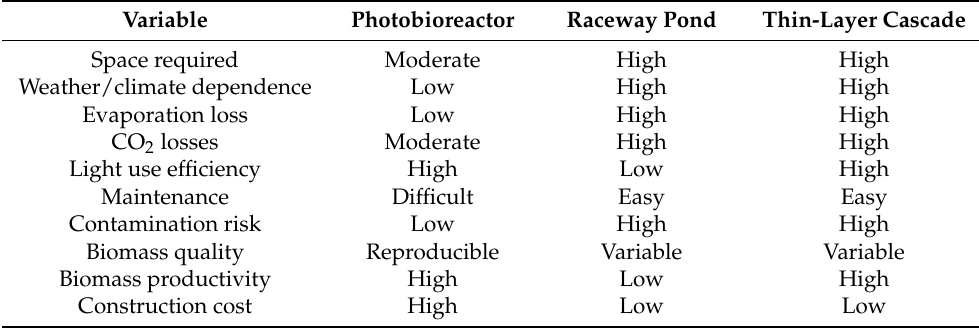
Table 1. Comparison of advantages and disadvantages of basic types of cultivation units which are used for microalgae production (modified from